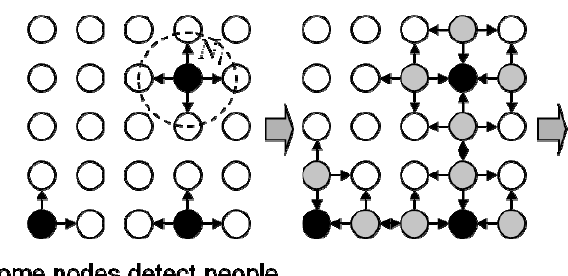
Figure 2. Two-dimensional schematic diagram of signal propagation for